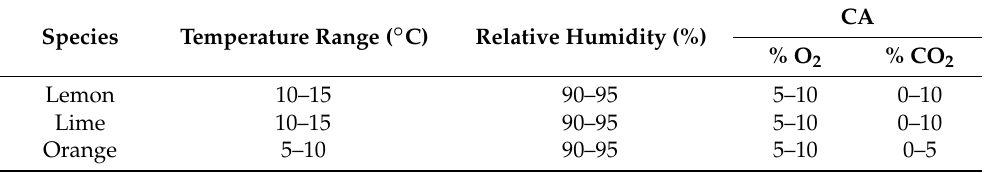
Table 2. Controlled atmosphere (CA) requirements for some citrus